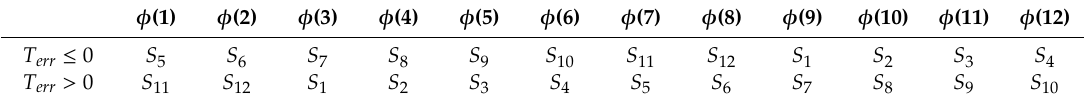
Figure 4. Illustration for the VVs selection for a single flux sector of ( a ) conventional PTC-DSVM [24] and ( b ) proposed PTC-DSVM. Table 2. Optimum space vector diagram zone for each flux sector.